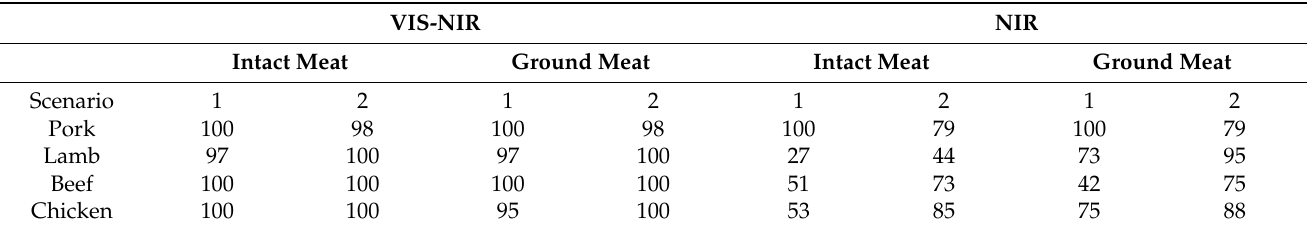
Table 3. Correct classification rate (%) of samples in two scenarios for the Vis-NIR and NIR